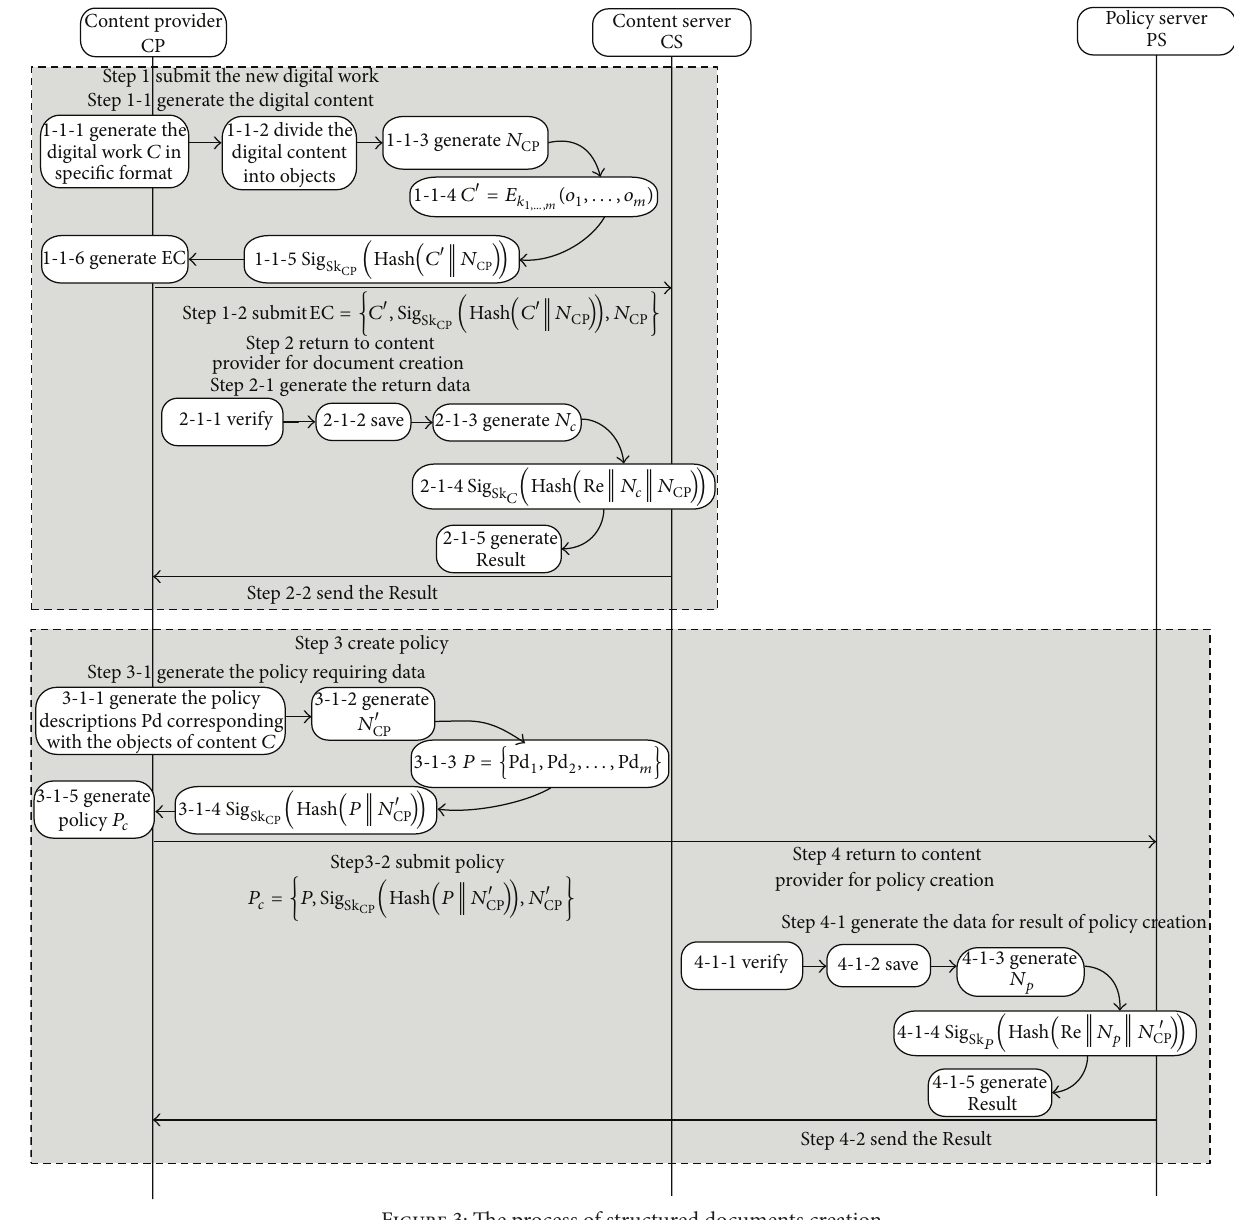
Figure 3: The process of structured documents